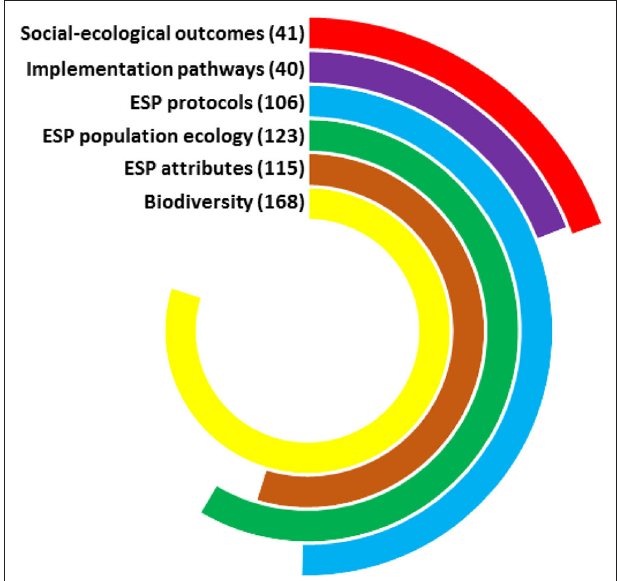
FIGURE 3 | Progress of biological control science along a six-step, outcome-oriented “impact pathway” for all Asian countries over a 50-year time frame. Within the concentric donut chart, the exact circumference of each loop mirrors the relative amount of scientific attention to a given research theme. For a given theme, the respective amount of scientific attention is expressed by the number of publications covering this theme. Themes include the measurement of farm-level biodiversity (inner-most circle) or a characterization of key attributes of ecosystem-service providers (ESP), to ultimately culminate in the envisioned social-ecological outcomes. Social-ecological outcomes also include crop yield (i.e., primary productivity) as imperfect proxy of farmer income or farm-level revenue, both important in achieving agro-ecological